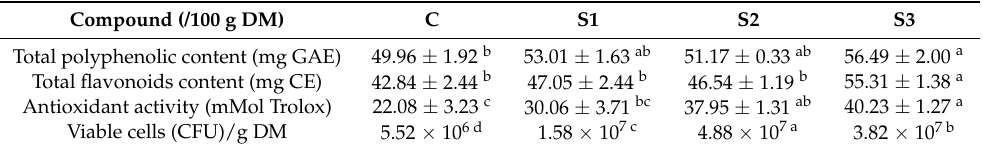
Table 4. Global phytochemical content, antioxidant activity and viable cell counts of value-added fermented soya